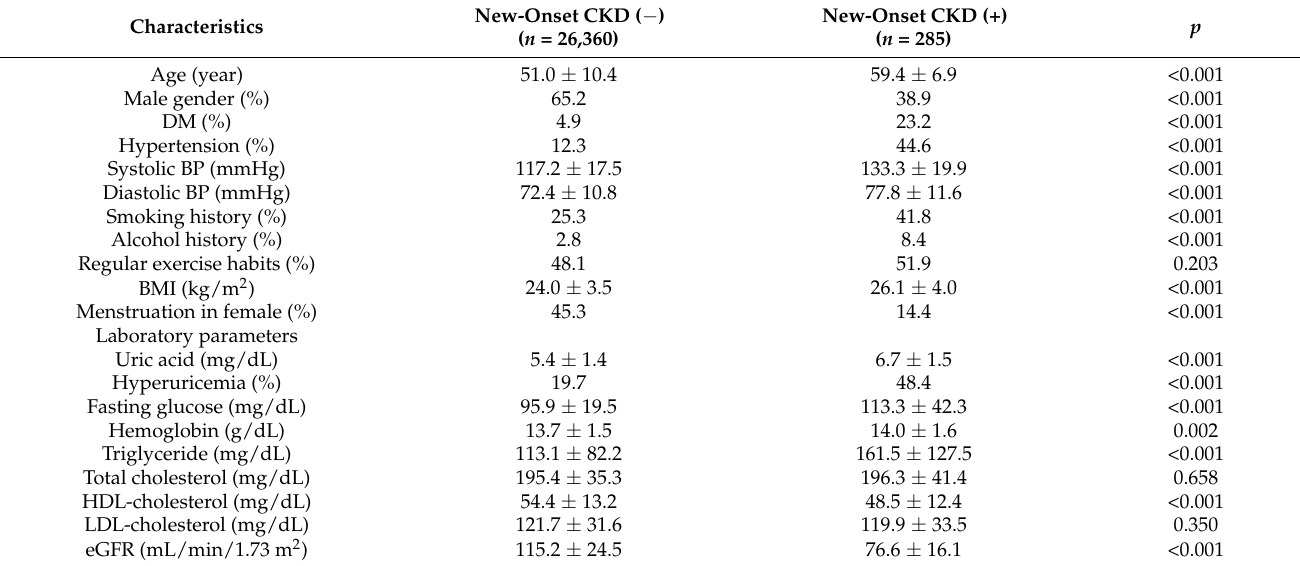
Table 1. Comparison of clinical characteristics among participants without or with new-onset CKD.